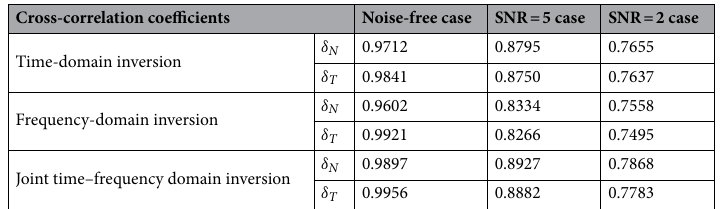
Table 1. Cross-correlation coefficients between true and inverted fracture weaknesses in time, frequency, and joint time–frequency domain.